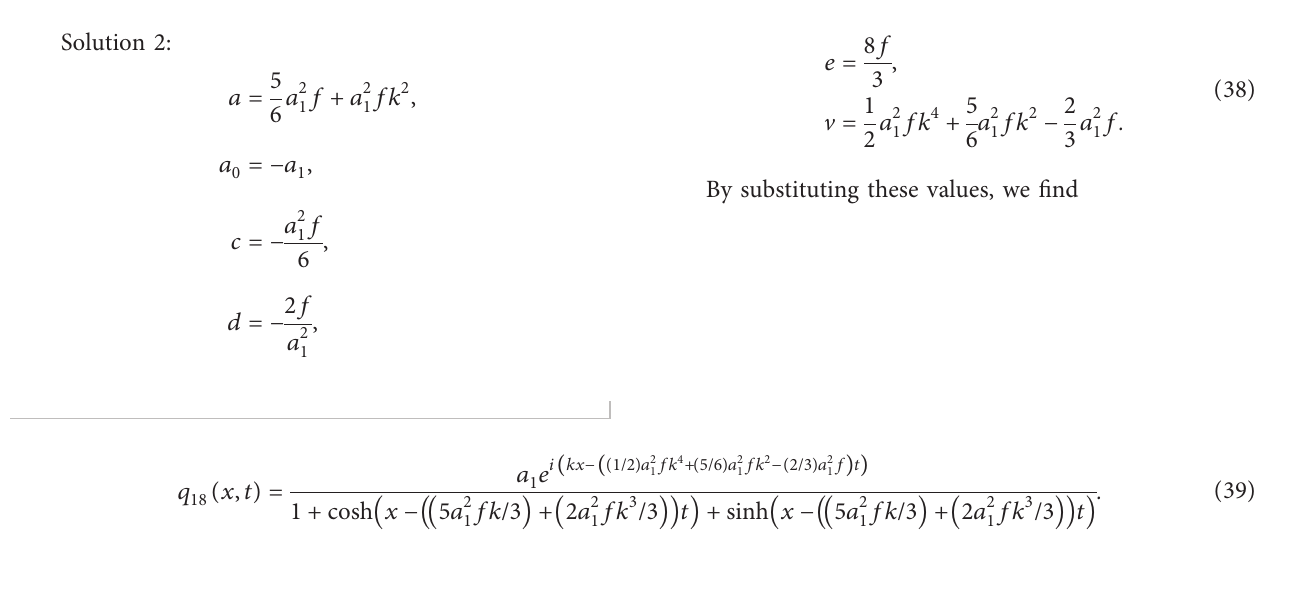
( x,t )| when a � − 4 , f � 0 . 7 ,k � − 3 . 5 withintheinterval − 5 ≤ x ≤ 5 , − 5 ≤ t ≤ 19 1